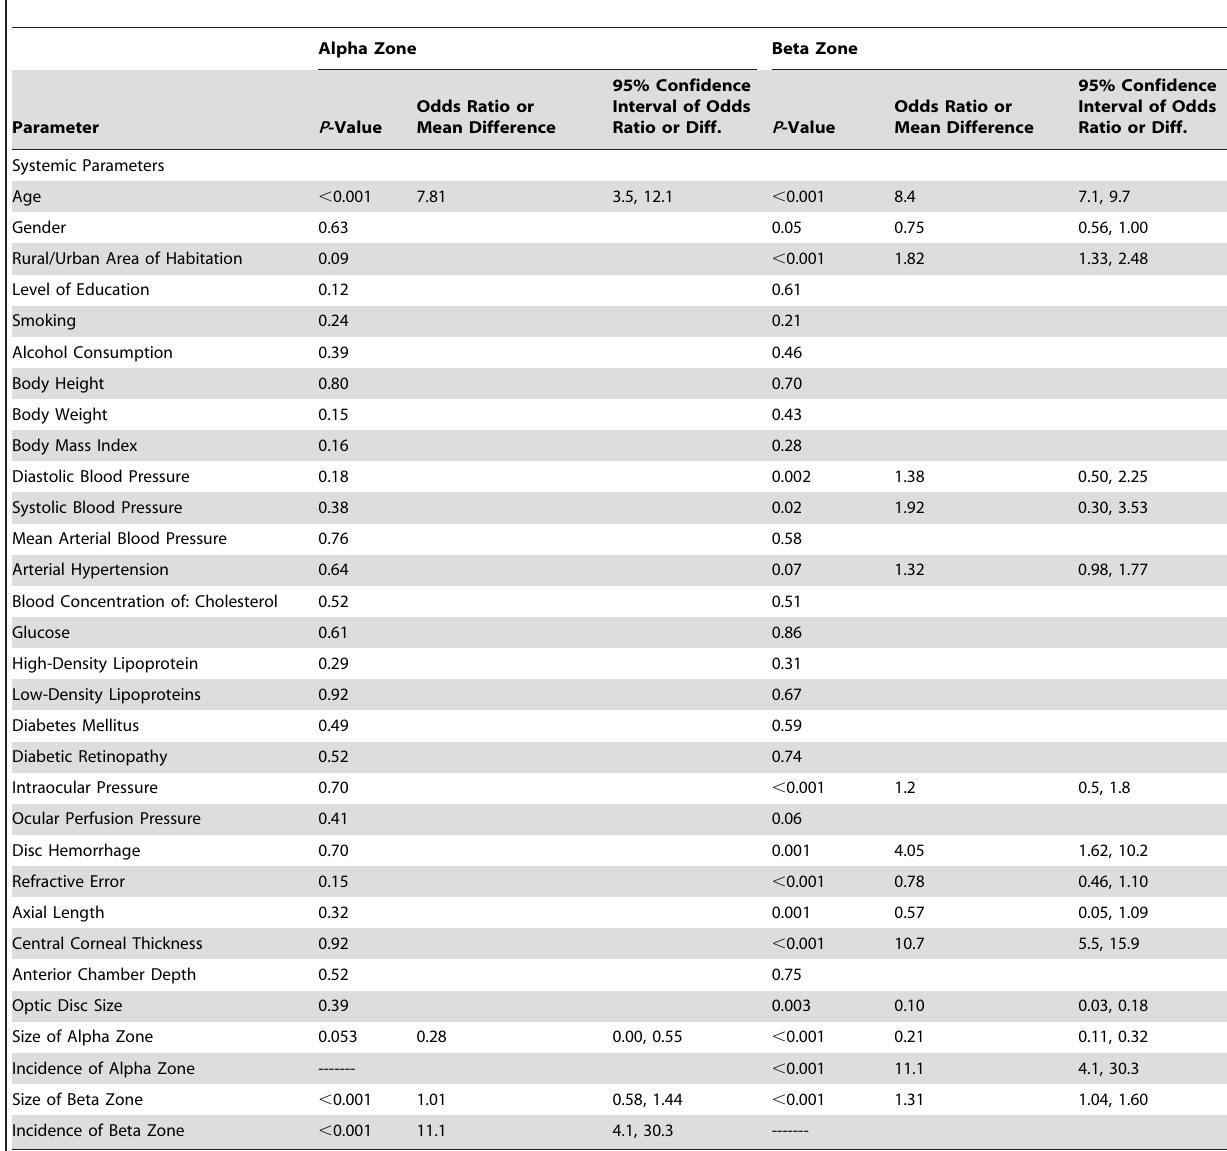
Table 1. Associations of the 5-Year Incidence of Alpha Zone and Beta Zone of Parapapillary Atrophy in the Non-Glaucomatous and Non-Highly Myopic Participants of the Beijing Eye